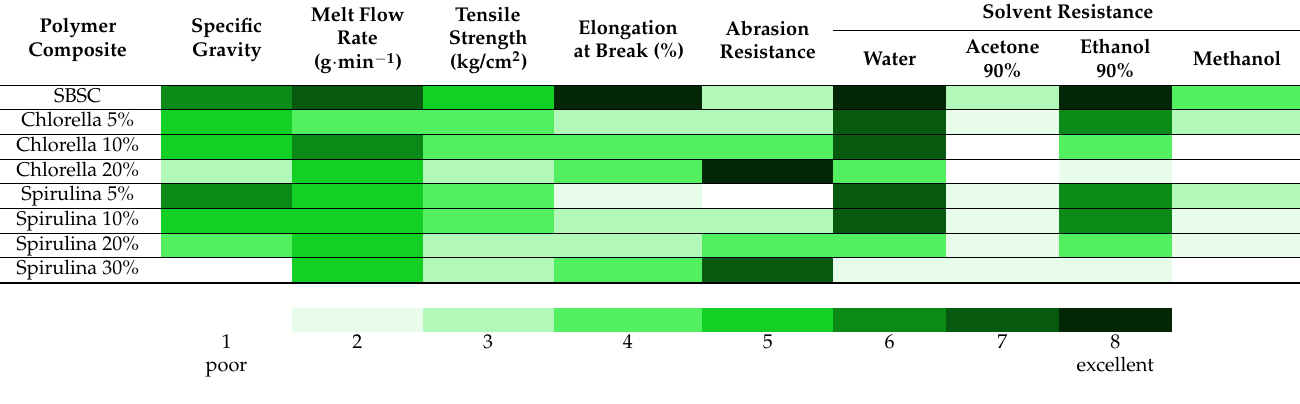
Table 5. Qualifications given to the SBS and MSBS composites, based on experimental recorded